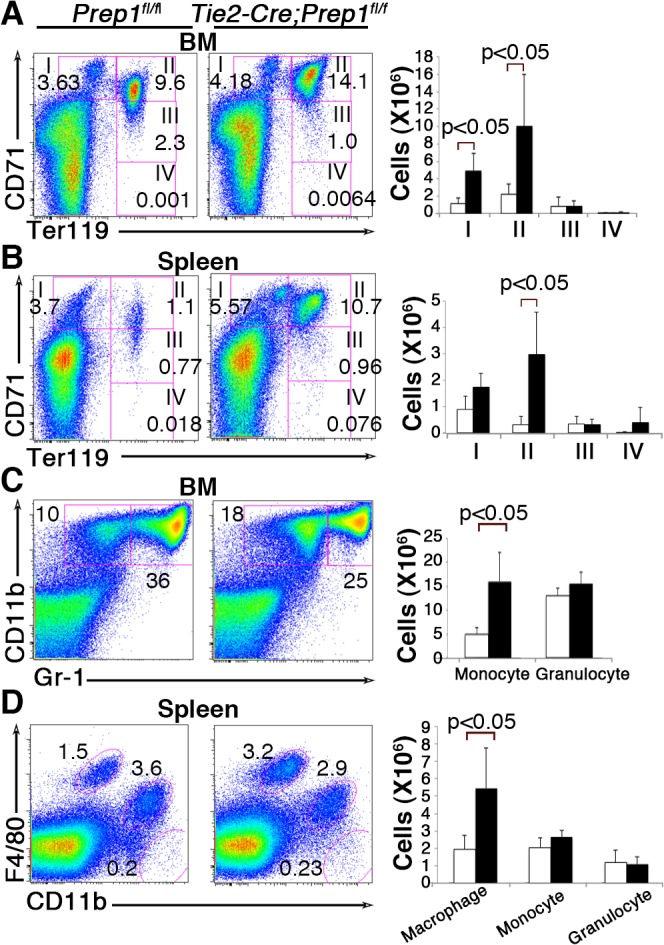
Impact of Prep1 loss on the differentiation of erythroid- and myeloid-lineage cells.(A, B) Representative flow cytometric profiles of erythroid-lineage cells in the BM (A) and spleen (B). Numbers indicate percentage of gated cells among the total cells analyzed. Roman numerals indicate the developmentally defined subpopulations of erythroblasts: I, proerythroblasts; II, basophilic erythroblast; III, polychromatophilic erythroblasts; IV, orthochromatophilic erythroblasts. Bar graphs on the right depict absolute numbers of the indicated cell populations in the BM of two femurs and the whole spleen in Tie2-Cre; Prep1fl/fl (solid bars) and control Prep1
flfl littermate (open bars) mice (mean and SD; n = 4). (C, D) Representative flow cytometric profiles of myeloid-lineage cells in the BM (C) and spleen (D). Numbers indicate percentage of gated cells among the total cells analyzed; granulocytes (Gr-1+ CD11b+) and monocytes (Gr-1- CD11b+) in C, granulocytes (F4/80- CD11bhigh), monocytes (F4/80dull CD11bdull) and macrophages (F4/80high CD11blow). Bar graphs on the right depict absolute numbers of the indicated cell populations in the BM of two femurs and the whole spleen in Tie2-Cre; Prep1fl/fl (solid bars) and control Prep1
flfl littermate (open bars) mice (mean and SD; n = 4).